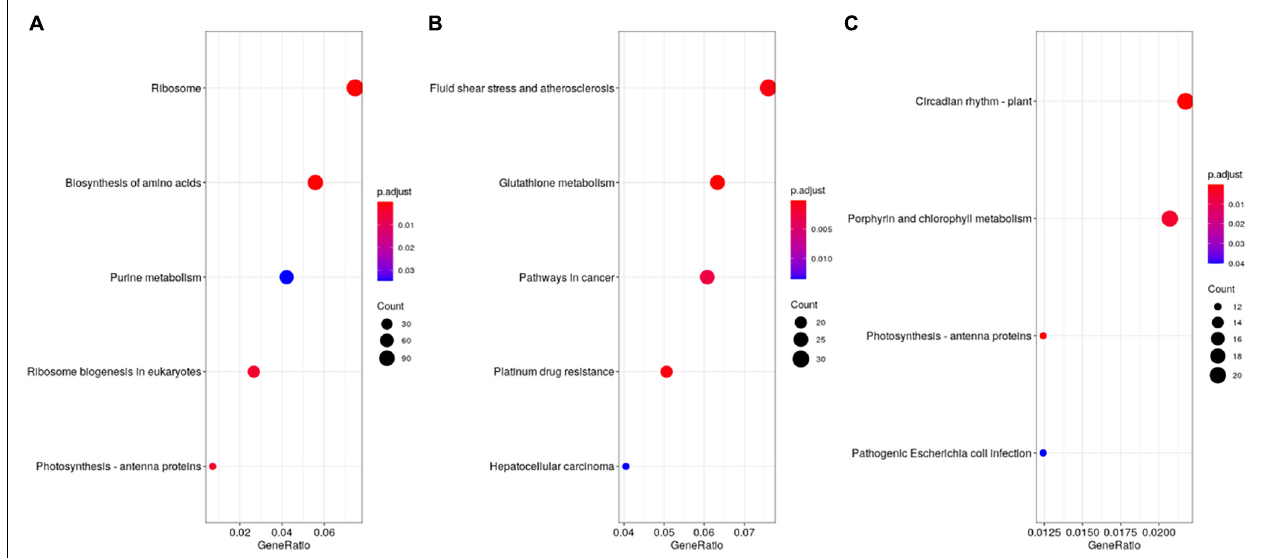
FIGURE 4 | KEGG enrichment of differentially expressed genes in the four development stages of sorghum. (A) stage1_stage2. (B) stage2_stage3. (C) stage3_stage4. TABLE 3 | Circadian rhythm- and hormone signal transduction-related enriched genes. Pathway Gene number Comparison (Log2 fold change) Function